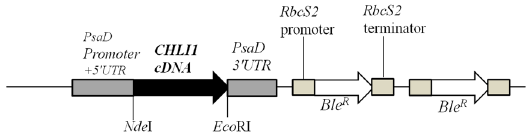
Figure 8. A schematic figure of the pDBle vector used for complementation of chli1-1 . Nde I/ Eco R1 double digested CHLI1 cDNA (1260 bp) was cloned into the Nde I/ Eco RI double digested pDBle plasmid. Primers used for amplification of CHLI1 cDNA are shown in Table 4. CHLI1 expression is driven by the constitutive PsaD promoter. Nde I and Eco RI restriction sites are labeled. pDBle contains two copies of Ble R genes driven by the Rubisco ( RbcS2 ) promoter. The size of the CHLI1 - pDBle construct is 7957 bp. Black arrow and white arrow denotes CHLI1 cDNA and Ble R gene, respectively. Grey boxes denote UnTranslated regions (UTR).